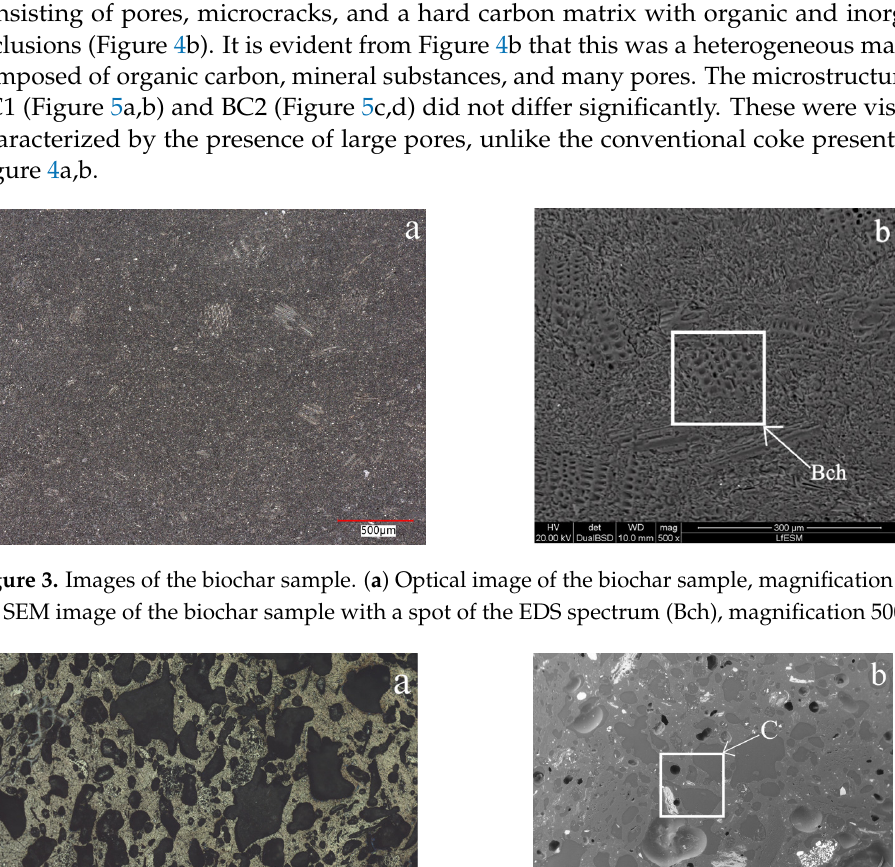
Figure 5. Microscopic images of the biocoke samples. ( a ) Optical image of the biocoke1 sample, magni fi cation 100×. ( b ) SEM image of the biocoke1 sample with a spot of the EDS spectrum (BC1), magni fi cation 100×. ( c ) Optical image of the biocoke2 sample, magni fi cation 100×. ( d ) SEM image of